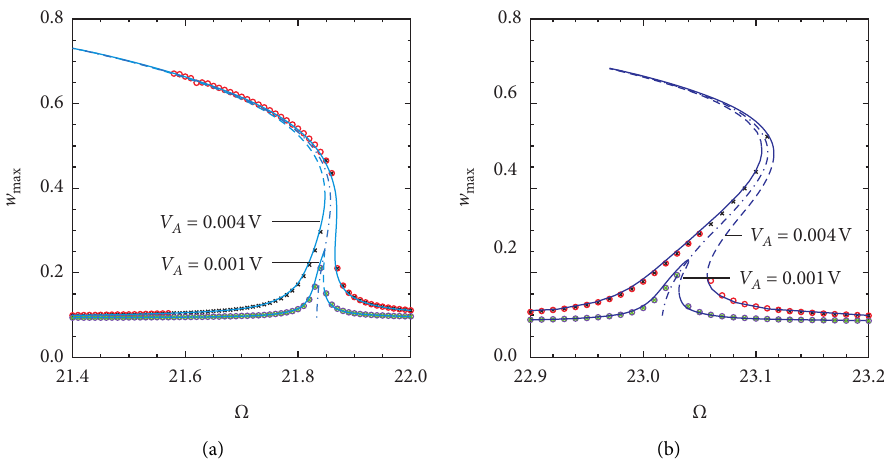
Figure 10: Amplitude-frequency curve: V